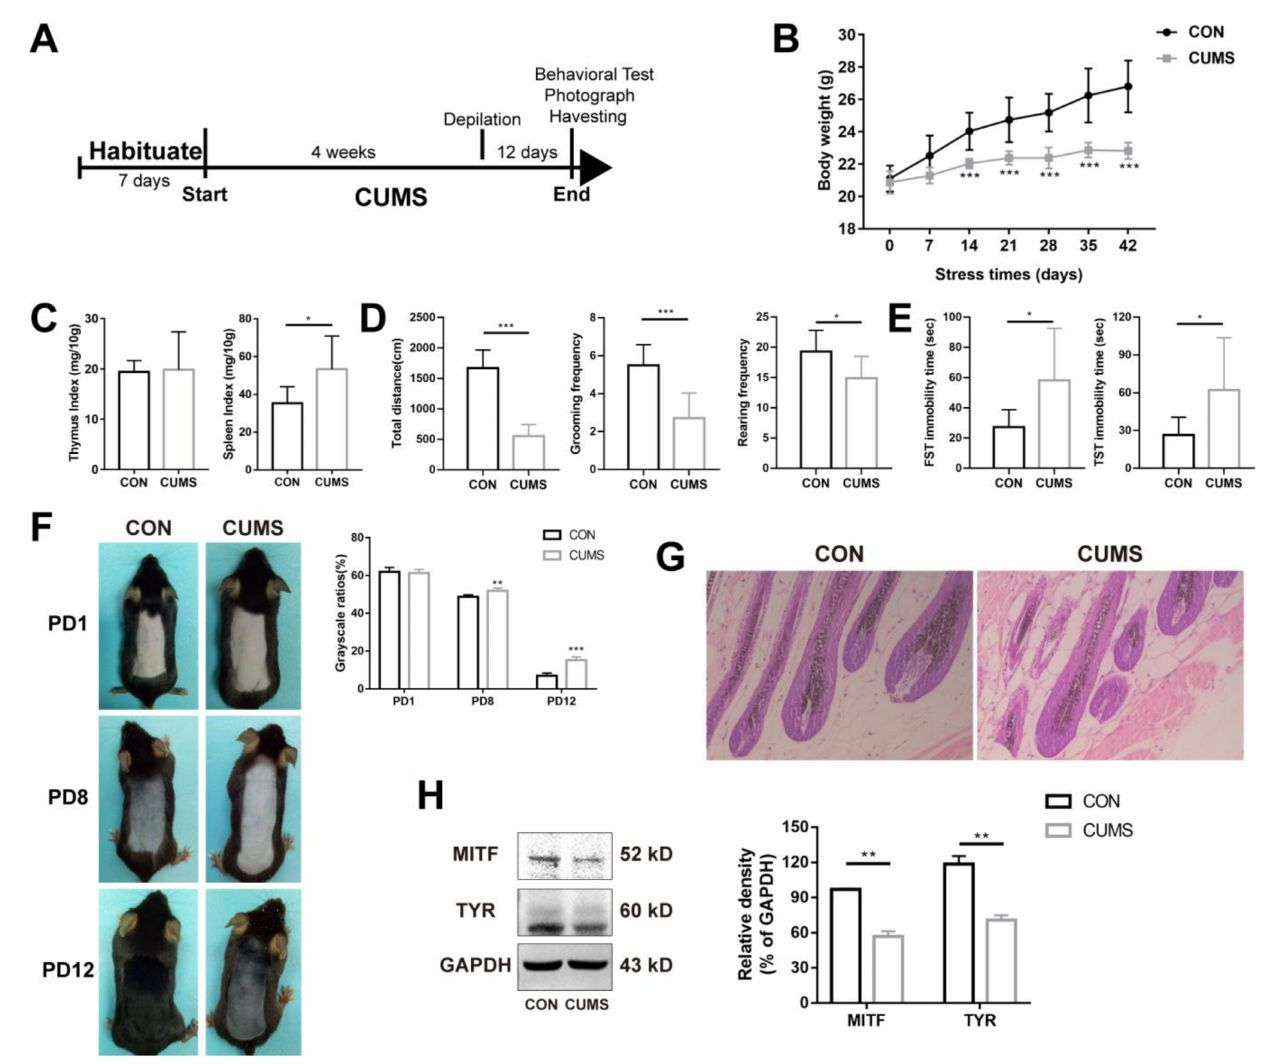
Figure 1. Chronic stress suppresses melanogenesis in the skin (n = 9). ( A ) The flowchart of CUMS modeling. ( B ) The effect of chronic stress on body weight. ( C ) The effect of chronic stress on the thymus index and spleen index. ( D , E ) The effect of chronic stress on spontaneous activity and behavioral despair in mice. ( F ) Effects of chronic stress on melanin synthesis in the back skin of mice. The grayscale ratio = mean grayscale/255. ( G ) H&E staining of the mouse skin. Magnification: 200 × . ( H ) The protein level of MITF and TYR were determined by Western blot analysis. Results were shown as mean ± standard deviation (SD) and were representative of three independent experiments. * p < 0.05, ** p < 0.01, *** p < 0.001, compared with CON. Two groups were tested using a t